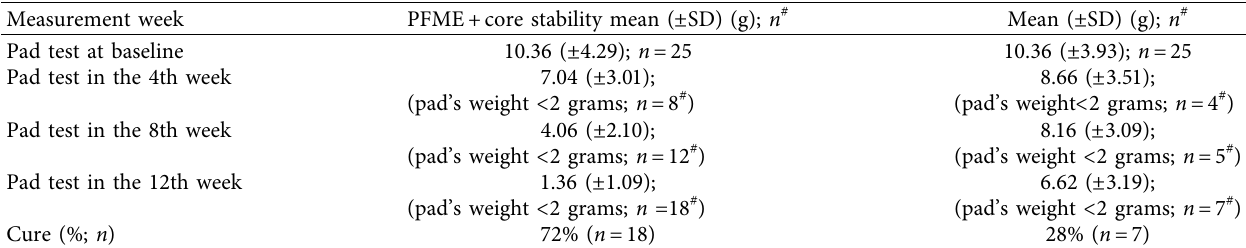
Table 2: The mean pad weight of the experimental and control groups at each week of intervention.